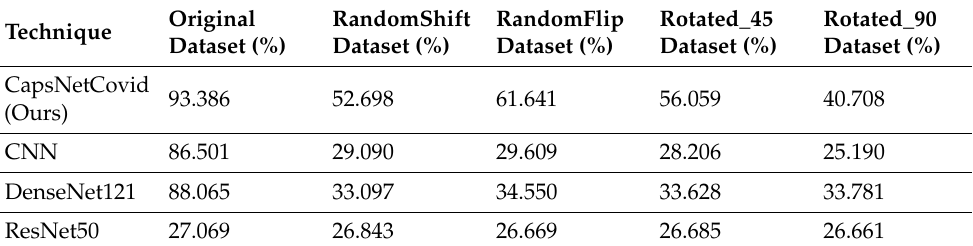
Table 14. F1-Score for CapsNetCovid, CNN, DenseNet121, and ResNet50 for multi-class classification. Technique